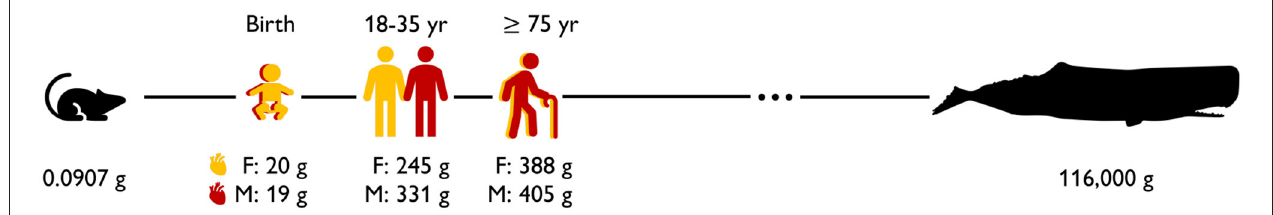
FIGURE 1 | Sex differences in the healthy human heart across life. At birth, the female heart is +5% larger than the male heart (Altman and Dittmer, 1962); during adulthood, the female heart becomes − 26 % smaller than the male heart (Molina and DiMaio, 2012, 2015); in the elderly, differences become less pronounced and the female heart is − 4 % smaller than the male heart (Sheikhazadi et al., 2010). Mouse (Slawson et al., 1998) and whale (Race et al., 1959) hearts are shown for